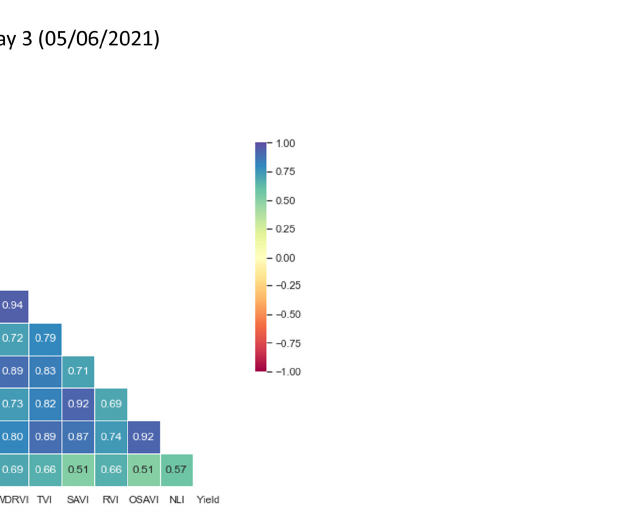
Figure 3. Correlation matrix between the different VIs of the three days (Days 1–3). The last column shows the correlation with the wheat grain yield. In terms of the relationship between the different VIs and yield, the highest values were measured for Day 2 (GS39-49). Except for the negative correlation of CI (−0.65), the values ranged from 0.81 for GRVI to 0.73 for GDVI. In comparison, for Day 3 (GS 69–75), the correlations ranged from 0.72 for GNDVI to 0.54 for GDVI. Although the increase in correlation is not significant (−0.66 compared to −0.65), CI was the only VI that increased the correlation. The lowest correlations were found with the VIs of Day 1 (Figure 3), with values ranging from 0.51 (RVI and GRVI) to 0.26 for GDVI. The correlation of CI was in- verse (−0.45). Overall, the highest value was obtained with GRVI for all three dates, whereas GDVI exhibited the lowest values.